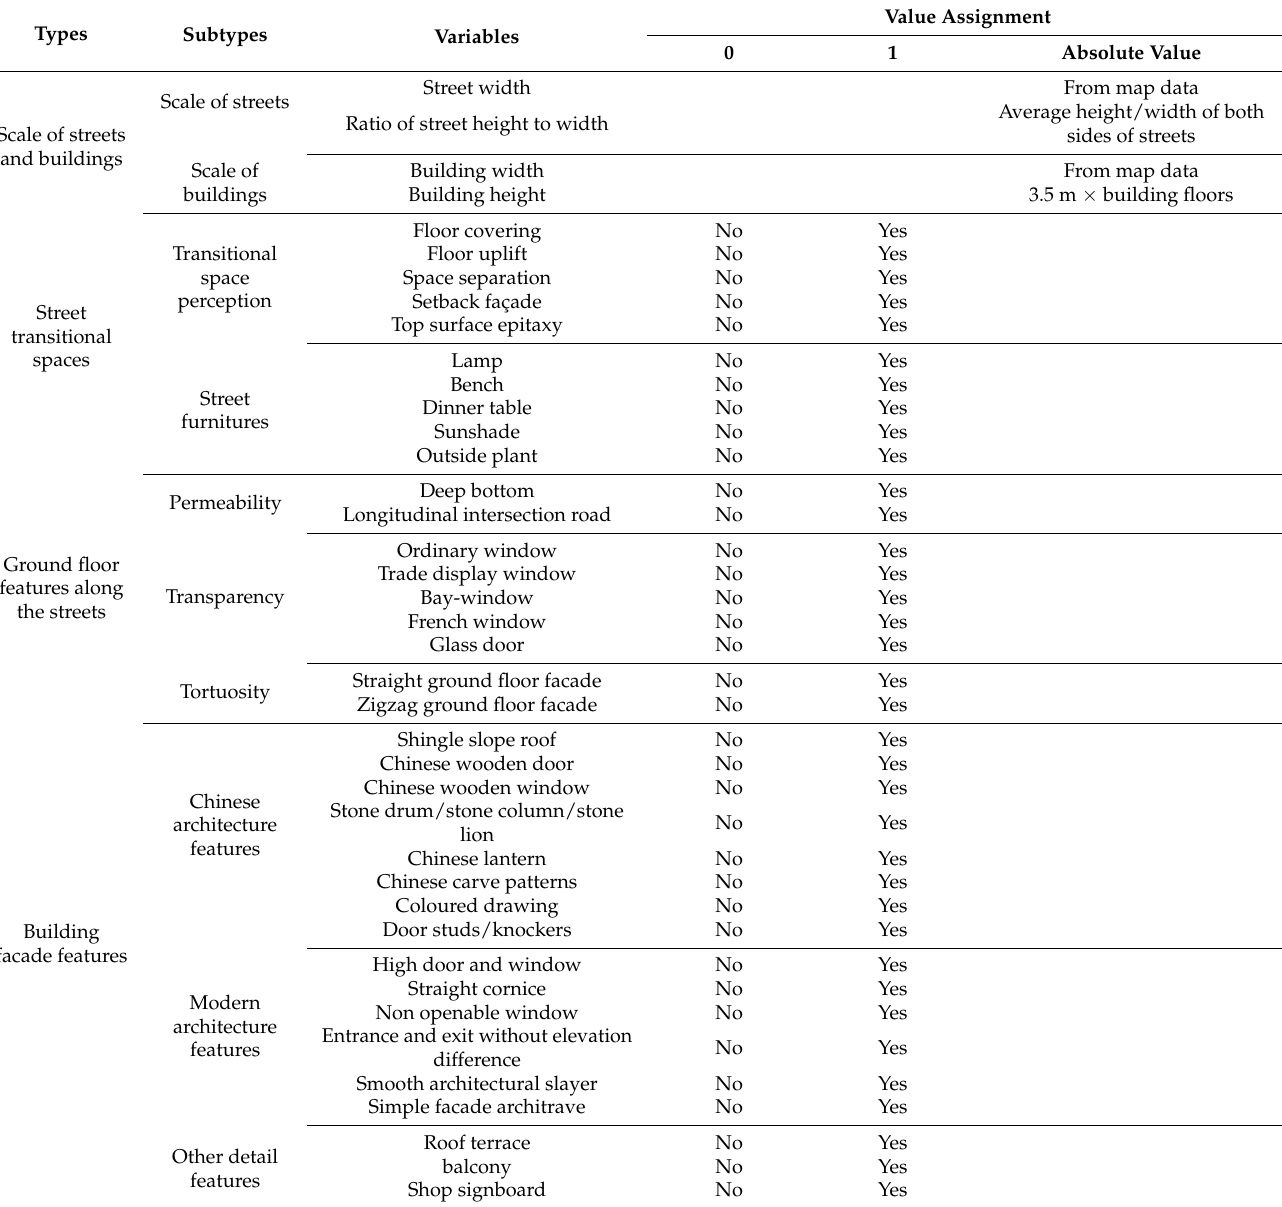
Table 2. Micro-scale built environment variable system and its value assignment